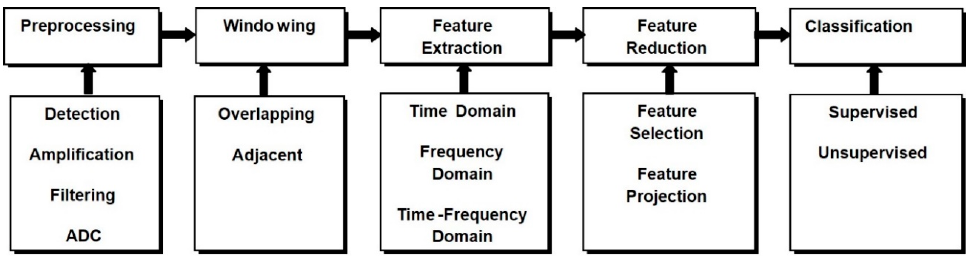
Figure 7. EEG signal decoding steps.